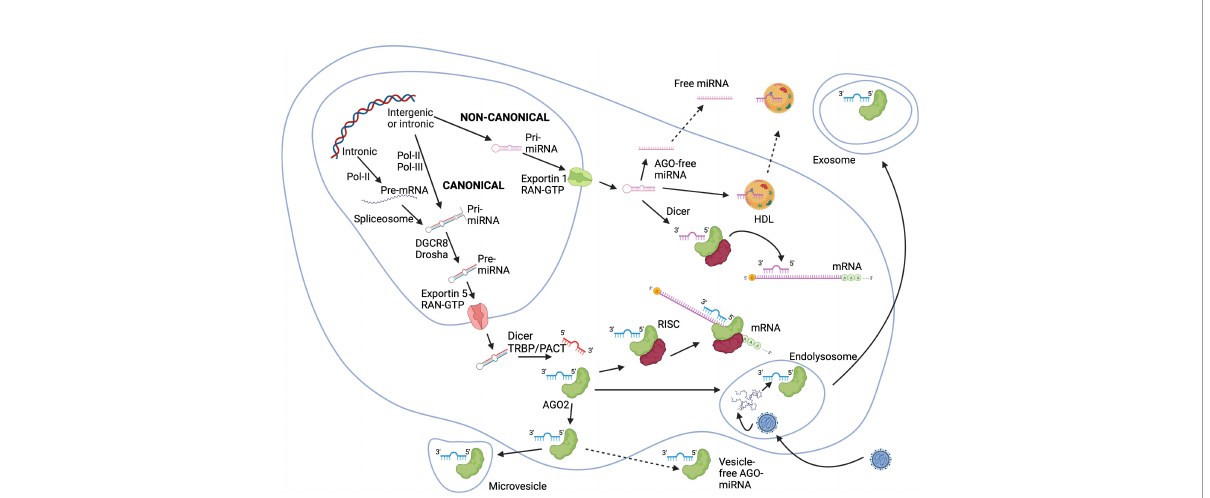
FIGURE 2 miRNA biogenesis via canonical and non-canonical pathways. In the canonical pathway, pri-miRNAs are turned into pre-miRNAs by the action of DGCR8 and Drosha within the nucleus. Intronic miRNAs can originate from host mRNA transcripts and processed into pre-miRNA by the spliceosome. Pre-miRNAs are exported into the cytoplasm through an exportin-5/RanGTP-dependent way, and are processed into mature miRNAs by Dicer with eventually RNA binding protein cofactors TRBP or PACT. In non-canonical pathways, shRNAs are cleaved by the DGCR8/ Drosha complex and exported into the cytoplasm by exportin-1 before Dicer processing. Mature miRNAs bind to AGO proteins forming RISCs, which in turn silence or cleave mRNAs. Alternatively, miRNA-AGO complexes are exported out of the cell via vesicles (exosomes or microvesicles) or as vesicle-free complexes. miRNAs binding to HDLs are actively secreted. AGO-free miRNAs can be exported out of the cell as well. AGO, Argonaute; DGCR8, DiGeorge syndrome critical region gene 8; HDL, high density lipoproteins; miRNA, microRNA; mRNA, messenger RNA; PACT, protein kinase RNA activator; pre-miRNA, precursor-miRNA; Ran, Ras-related nuclear protein; RISC, RNA induced silencing complex; shRNA, small hairpin RNA; TRBP, transactivation response RNA binding protein. The Figure was created on